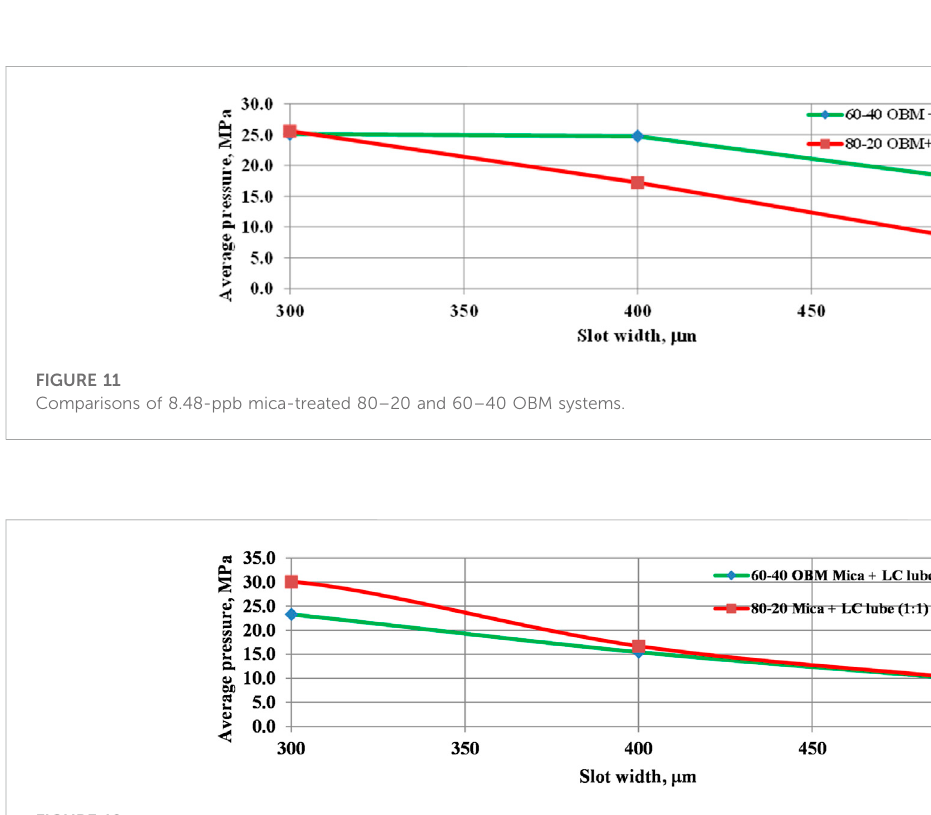
FIGURE 12 Comparisons of 8.48-ppb LC-LUBE + mica (1:1 ratio)-treated 80/20 and 60/40 OBM